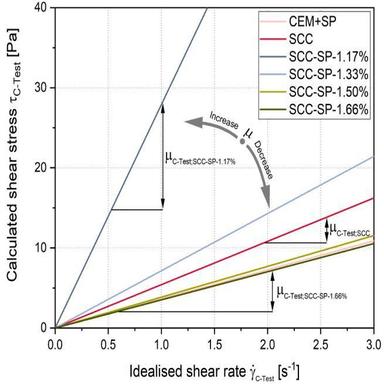
C-test viscosity determination method results, represented as a Newtonian fluid, enabling clearer visualisation of the differences in plastic viscosity.